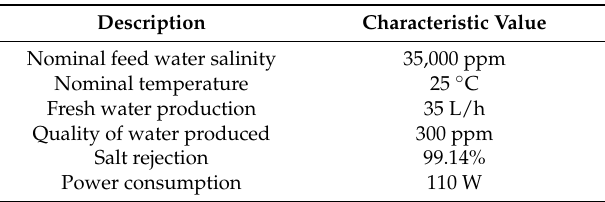
Table 2. RO technical characteristics [41].